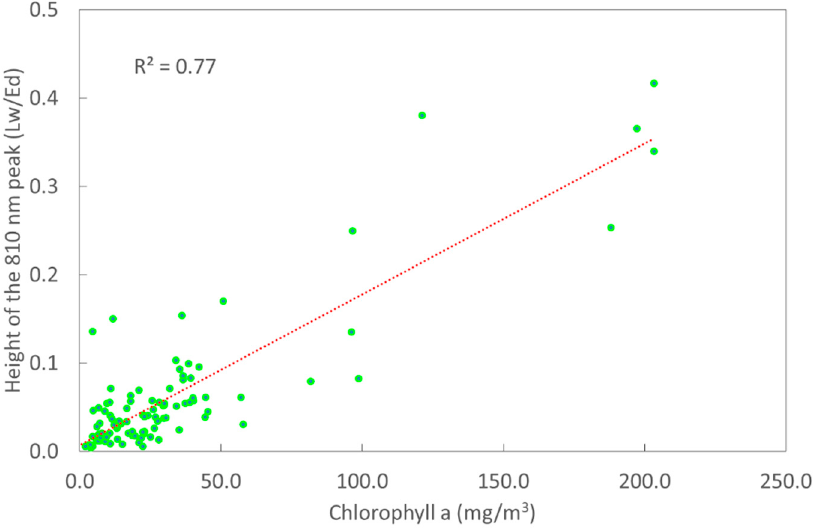
Figure 5. Correlation between the 810 nm peak height (P 2 , Equation (2)) and chlorophyll-a concentration in all studied Estonian and Swedish lakes.